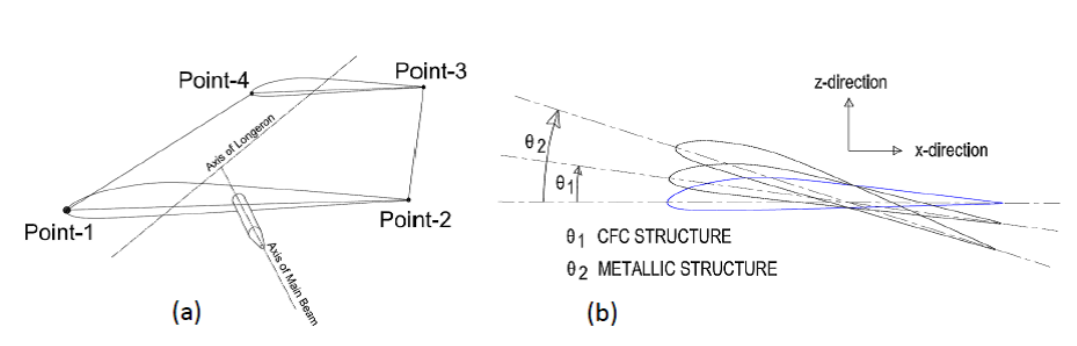
Figure 8: (a) Point locations for Twist data (b) Twisting angle for CFC and Metallic Structure